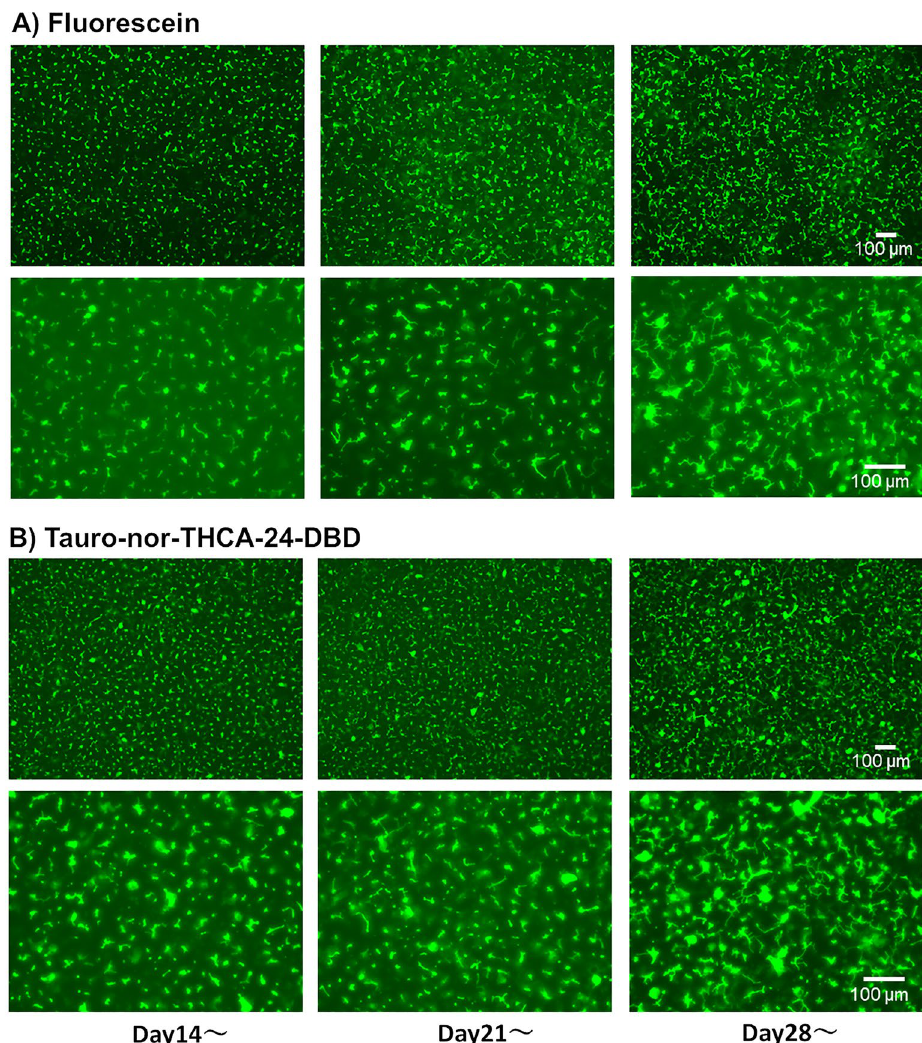
Figure 1. Accumulation of model fluorescein substrates into bile canaliculi when the culture conditions for the formation of extended bile canaliculi were examined. Human-induced pluripotent stem cell-derived hepatocytes were cultured in a long-term maintenance medium for 14 days, 21 days, and 28 days and then, they were sandwich-cultured in a maintenance medium for 9 days. Following the sandwich culture, the excretion of model fluorescein substrates (fluorescein diacetate and tauro-nor-THCA-24-DBD) into bile canaliculi was observed. Fluorescence images show ( A ) Fluorescein and ( B ) Tauro-nor-THCA-24-DBD, which were accumulated into bile